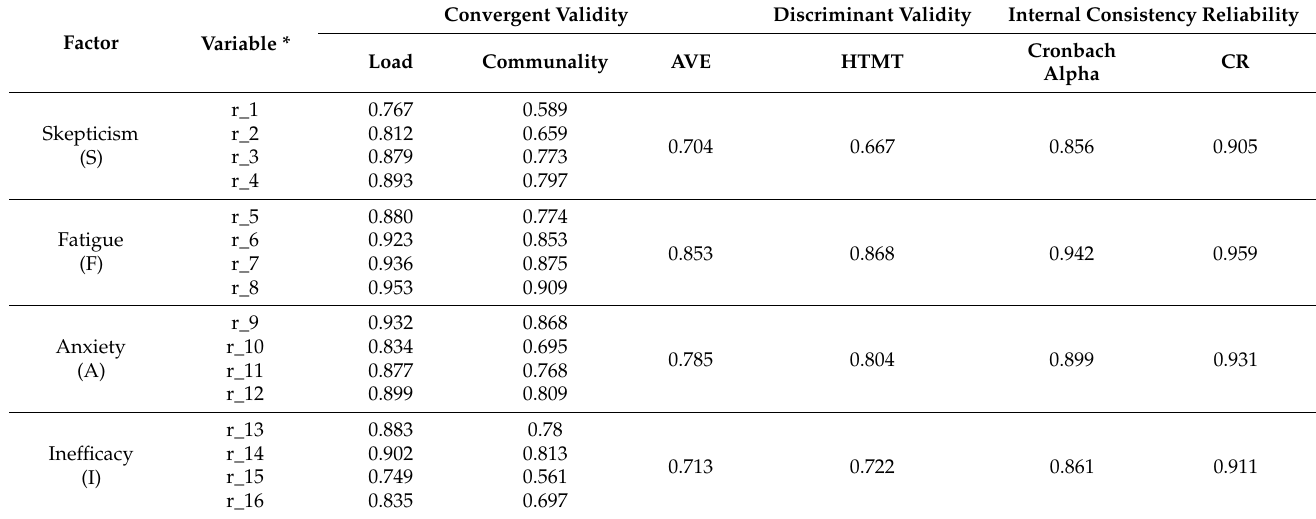
Table 3. Global measures of scale